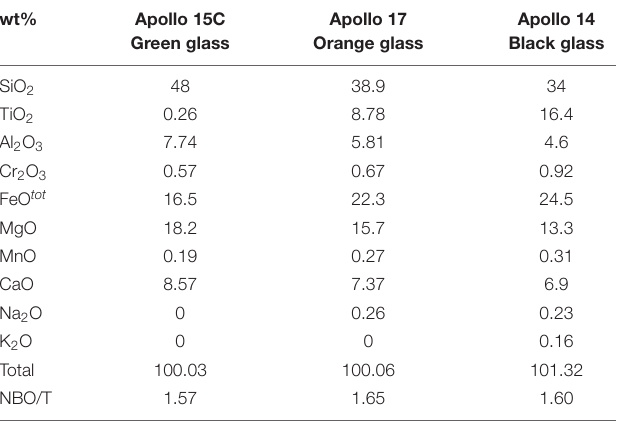
TABLE 1 | Compositions of synthetic Apollo green, orange, and black glasses based on electron microprobe measurements (from Delano, 1986). wt%